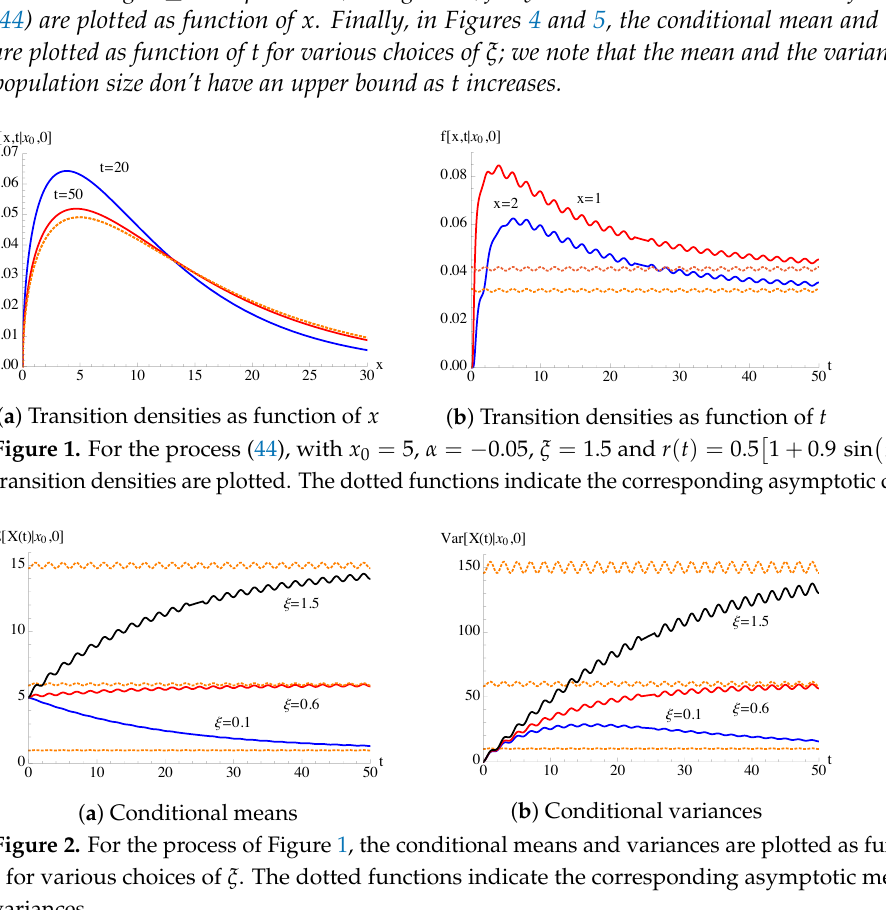
Figure 2. For the process of Figure 1, the conditional means and variances are plotted as function of t for various choices of ξ . The dotted functions indicate the corresponding asymptotic means and variances.